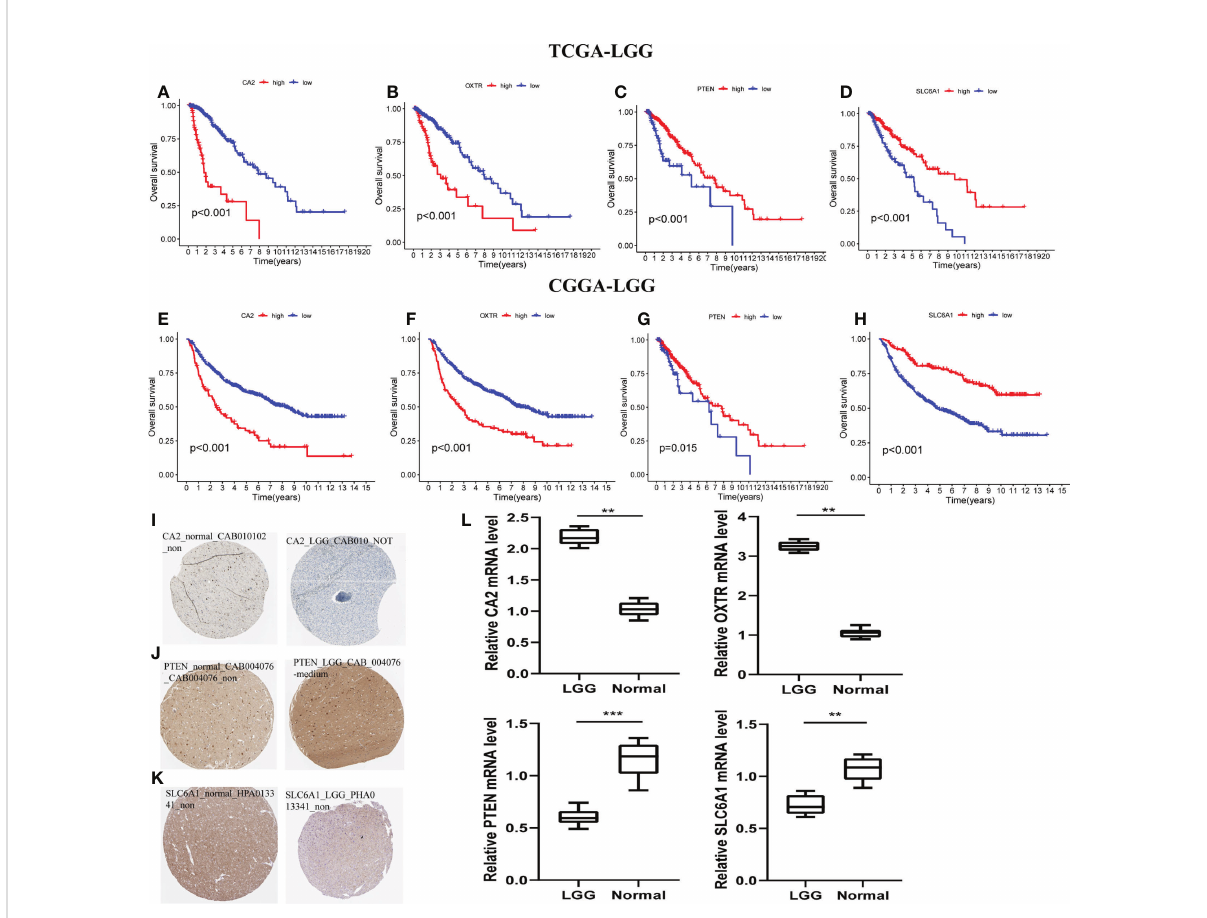
FIGURE 10 Veri fi cation of the prognostic value and expression of hub genes of GSRS. Survival analysis of CA2, OXTR, PTEN, and SLC6A1 for gliomas in TCGA (A – D) and CGGA (E – H) cohorts. The protein expression level of CA2 (I) , PETN (J) , and SLC6A1 (K) in normal and LGG tissues according to the HPA database. (L) The relative mRNA expression levels of CA2, PTEN, SLC6A1, and OXTR are compared among LGG and non-tumor tissues based on real-time PCR results. *** p < 0.001, ** p < 0.01.